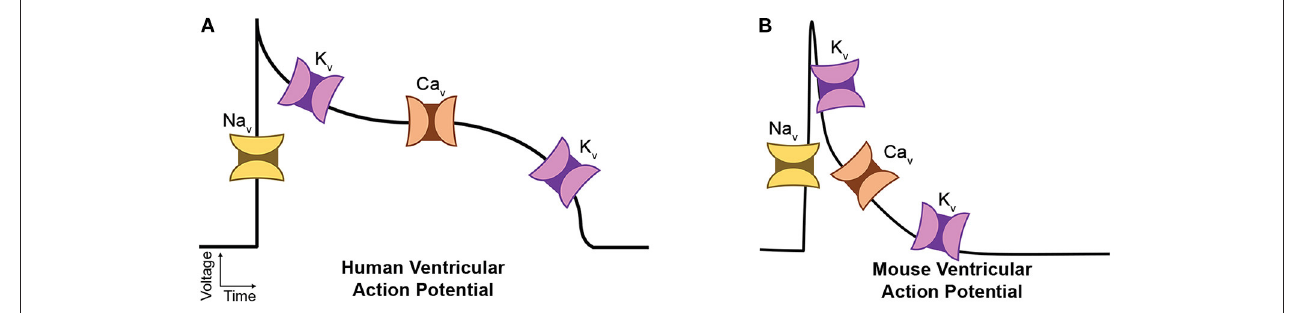
FIGURE 1 | Diagrams of major cardiac ion channels and their roles in the action potential. (A) Human ventricular myocytes. (B) Mouse ventricular myocytes.